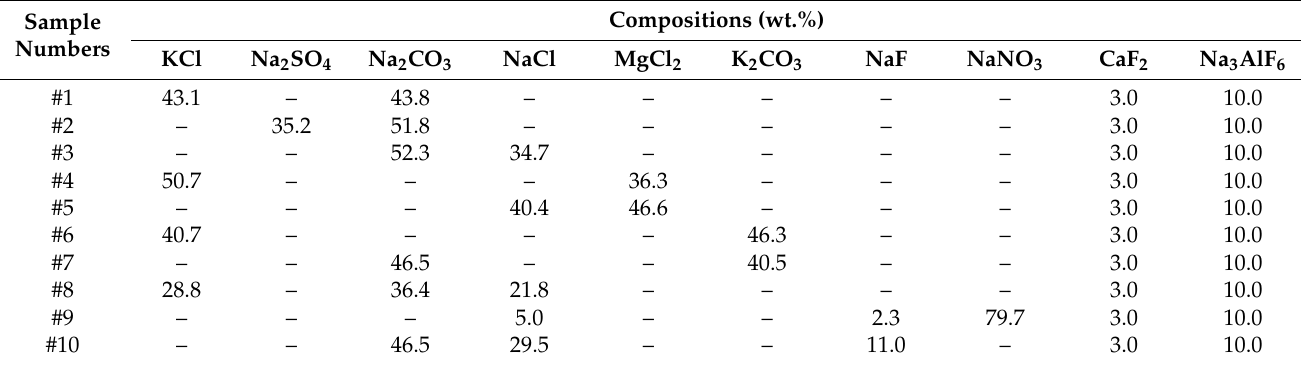
Table 3. Chemical compositions of experimental fluxes.